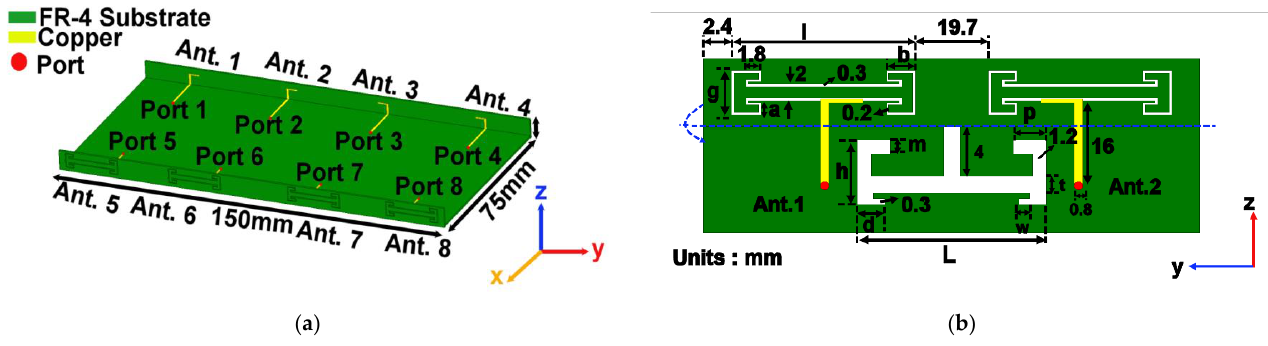
Figure 1. Proposed antenna view ( a ) front ( b ) antenna elements with decoupling element. Table 1. Proposed antenna dimensions.